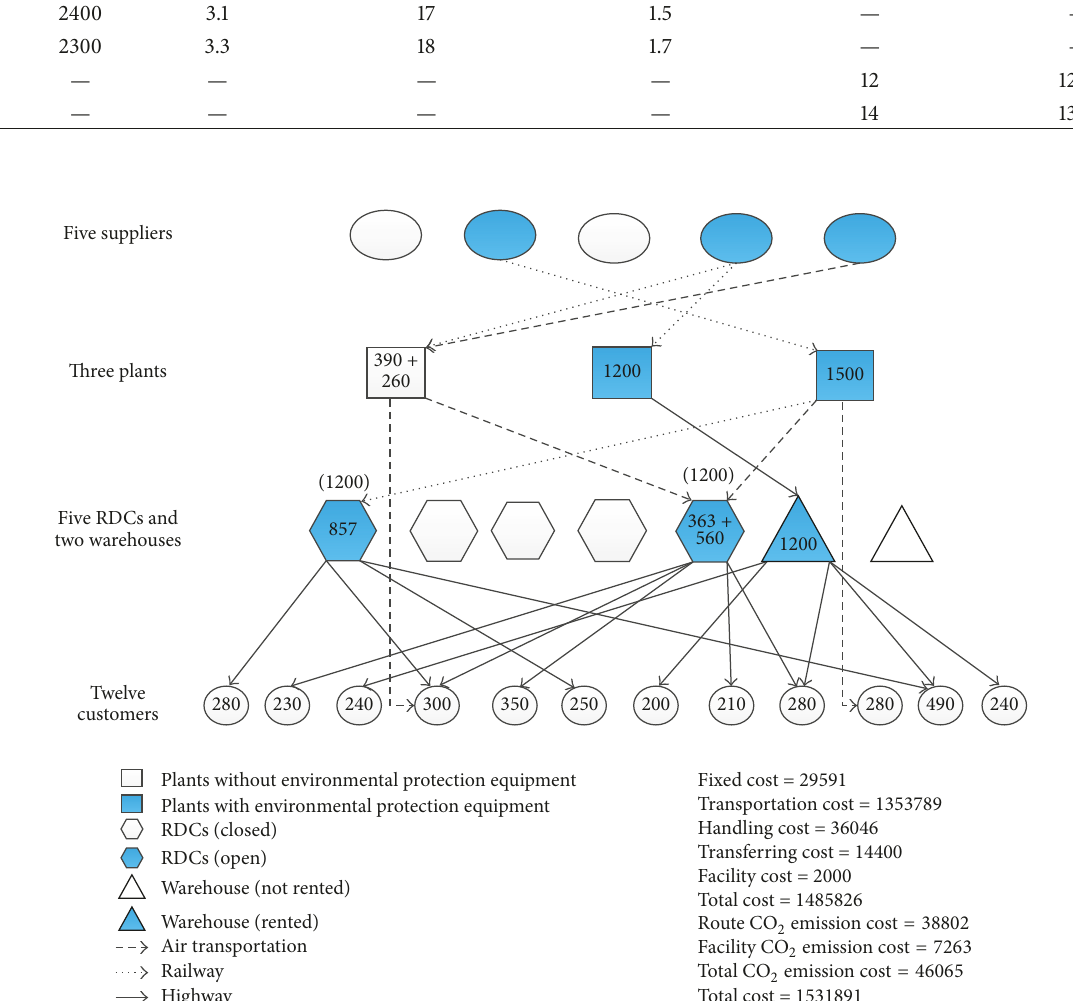
Figure 2: Supply chain network structure and related decision variables for the case.